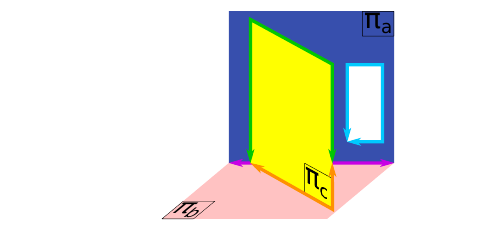
Figure 4. Example of contour lines for three interacting planar primitives. The orange line represents the interaction of the primitives π b and π c , the green line represents the interaction of π a and π c , the purple line represents the interaction of π a and π b , and the blue line shows the opening in the primitive π a .